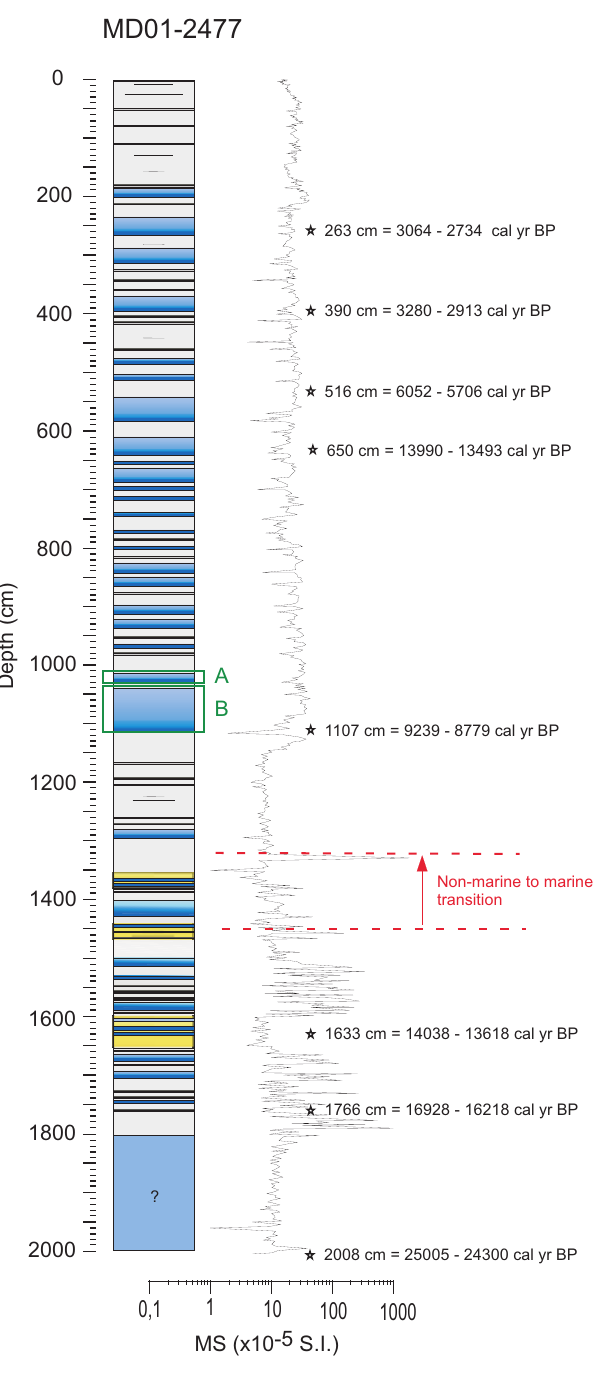
Figure 2. Simplified log of Core MD01-2477 displaying the distribution of the two types of sedimentary events. T: classical turbidites (grey); HT: association “homogenite + turbidite” (blue). The magnetic susceptibility (MS) profile underlines the difference between marine and non- marine successions. Rectangles refer to the two analyzed layers and their close up (on Figure 3 and